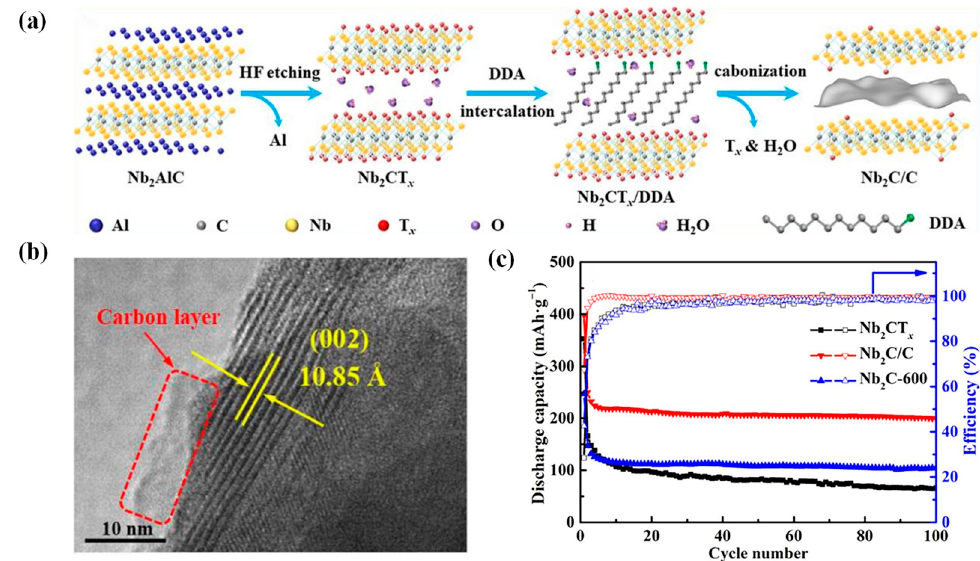
Figure 7. Applications of Nb 2 CT x in KIBs. ( a ) Schematic illustration for the synthesis of Nb 2 C/C, ( b ) HRTEM image of Nb 2 C/C, ( c ) Speci fi c capacity of Nb 2 C/C at 0.02 A/g. [58] Copyright Elsevier, 2022.